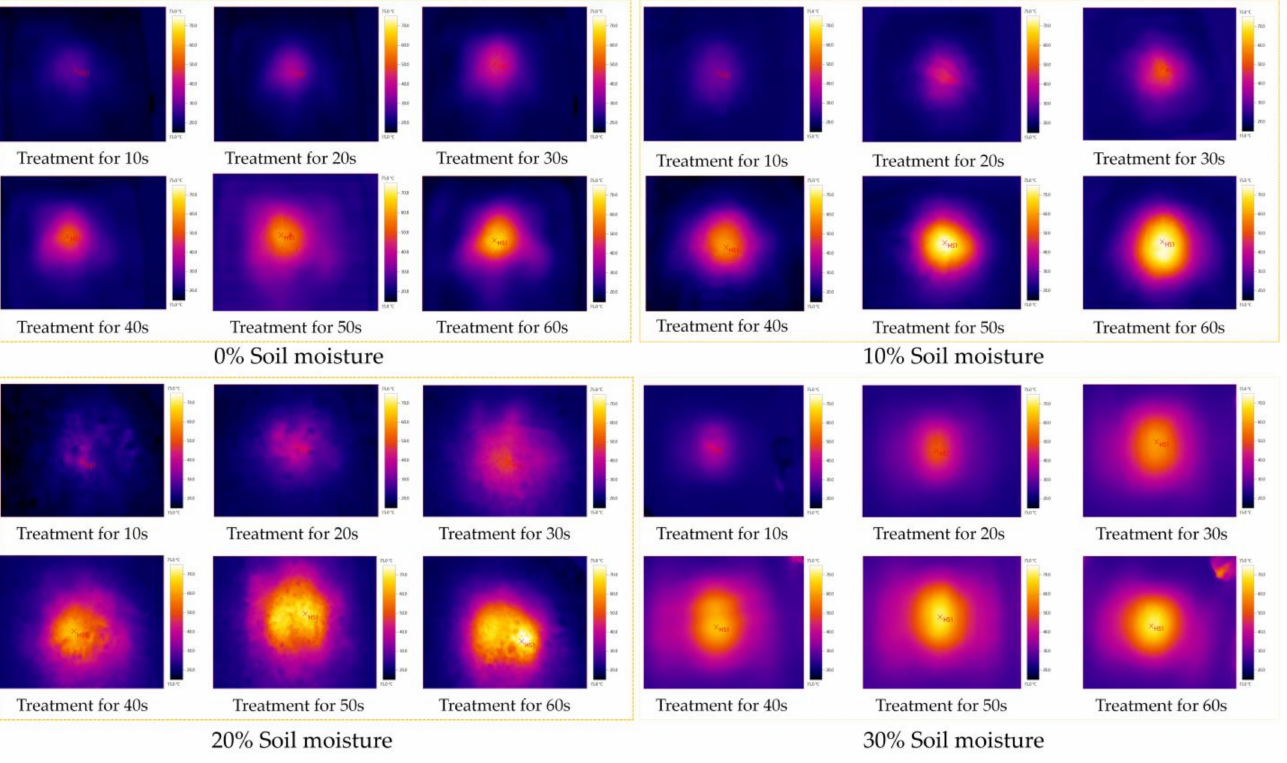
Figure 10. Thermal images of the soil surface under 2 kW microwave output power.